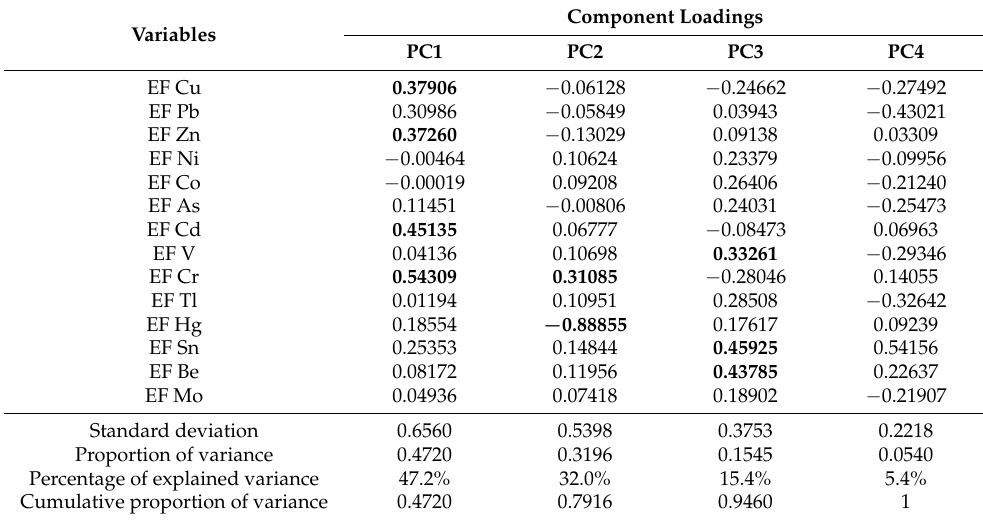
Table 3. Summary of RPCA performed on the EFs (Vesuvian area). Loading for every single variable is reported for the selected